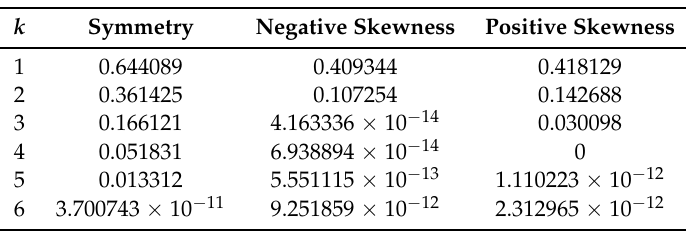
Table 1. Impact of skewness type on conditional probabilities (cid:98) ∆ 3 ( k ) for bounded discrete processing distribution and (cid:36) =